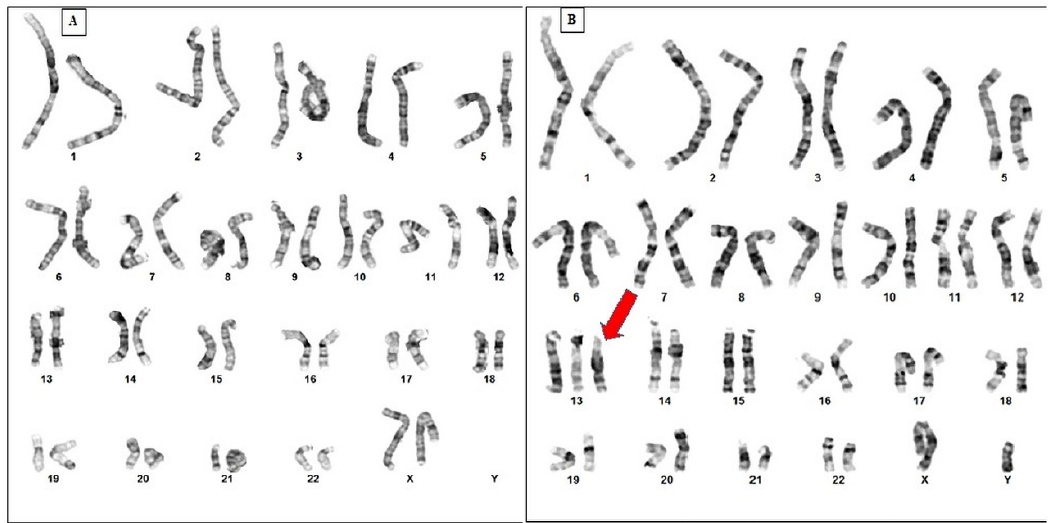
Figure 1. Karyotyping result; ( A ) Normal Karyotype of Healthy female and ( B ) Trisomy 13 in all cases (male = 20 and female = 17) of Patau Syndrome. Red arrow shows trisomy 13.